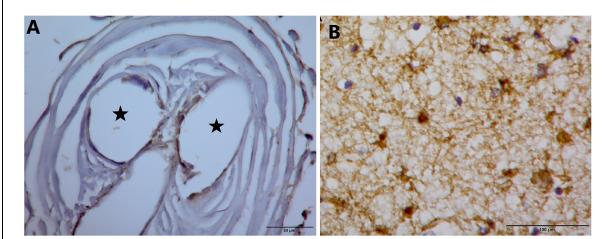
FIGURE 9 | (A) GFAP stain on tissue from inside the electrode tip does not demonstrate gliosis. Black stars indicate holes in tissue where once the